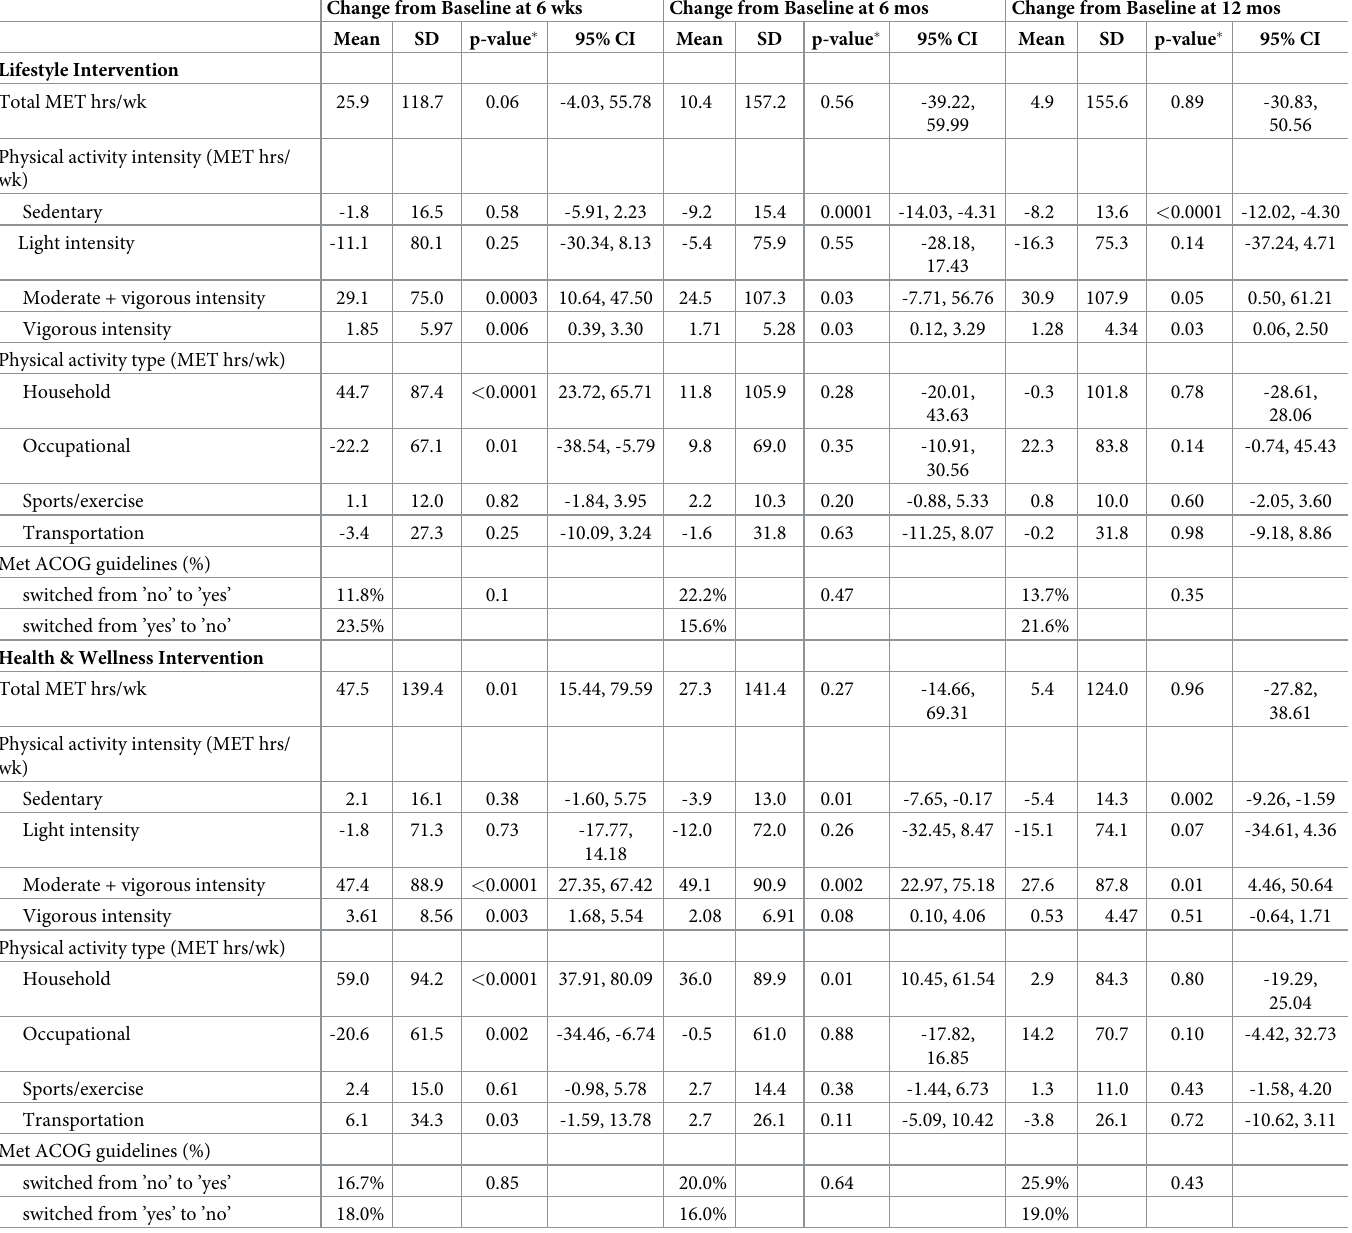
Table 3. Change in physical activity over follow-up according to intervention group; Estudio PARTO